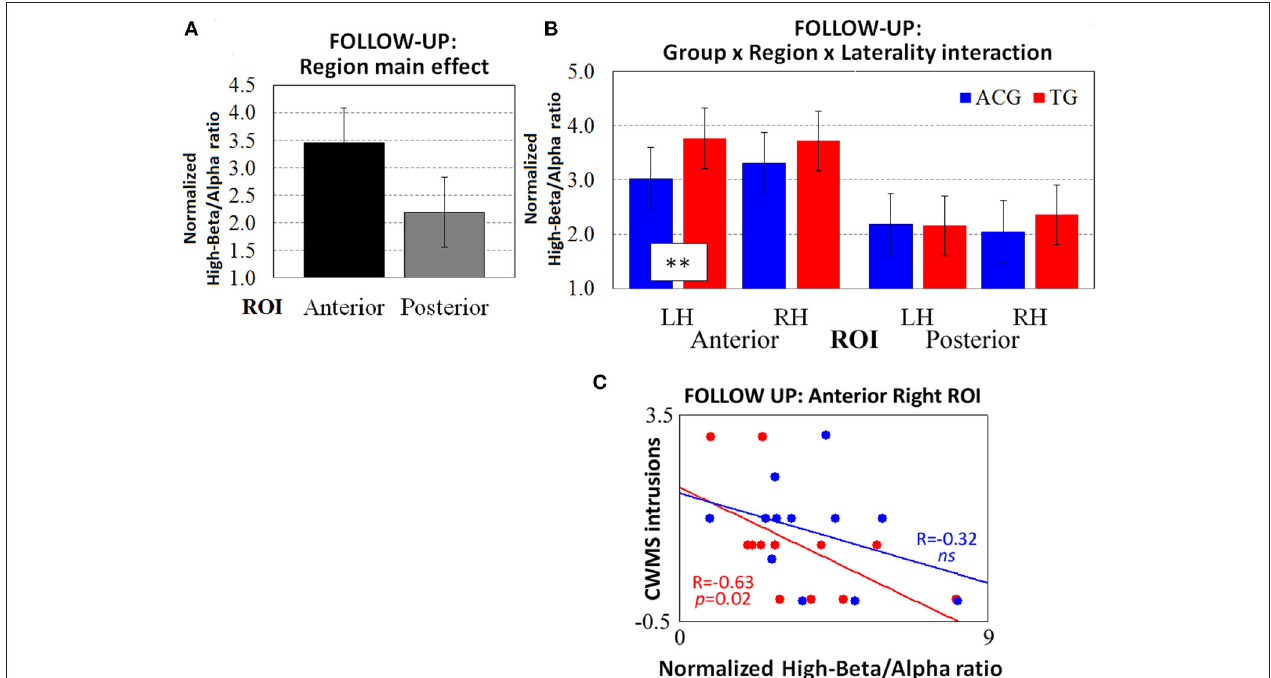
FIGURE 3 | The resting-state normalized high-beta/alpha index from the follow-up EEG data revealed (A) the main effect of region and (B) the three-way Group × Region × Laterality interaction ( tendency ). The Spearman correlations between high-beta/alpha indices on anterior right ROIs and CWMS follow-up intrusions (C) were significant in TG participants (red dots and lines) but not in ACG participants (blue dots and lines). ** p < 0.01 Tukey HSD post-hoc comparisons. TG: Trained Group; ACG: Active Control Group; LH: Left Hemisphere; RH: Right Hemisphere; CWMS: Categorisation Working Memory Span Test.